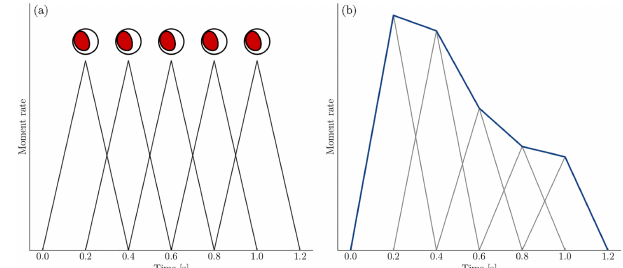
Figure 4. (a) Schematic sketch of five triangular basis functions h l (t) with an equal weight of 1 and with a duration of 0 . 4s each. The focal sphere symbols indicate that the orientation of the source mechanism is assumed to be constant during the rupture process. (b) Simulation of a complex moment rate function (blue line) by applying different weights to h l and linear